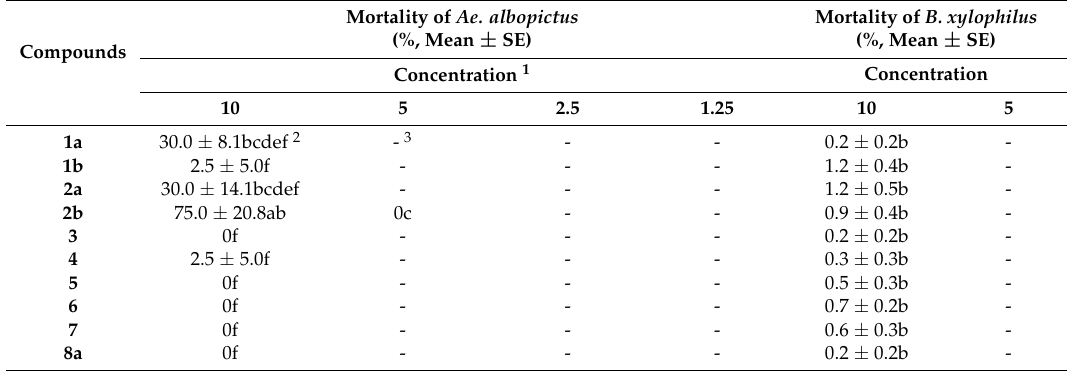
Table 1. Larvicidal and nematicidal activities of barbituric acids (see Figure 1) against Ae. albopictus and B.